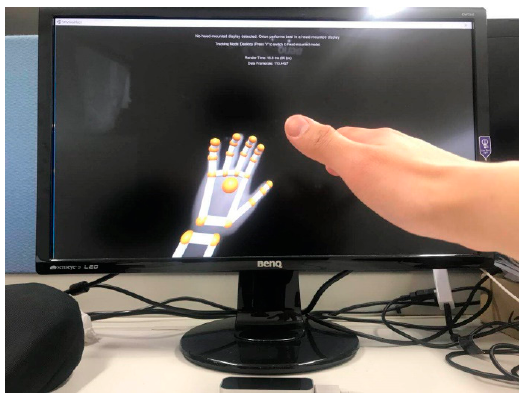
Figure 3. Working state of Leap Motion.